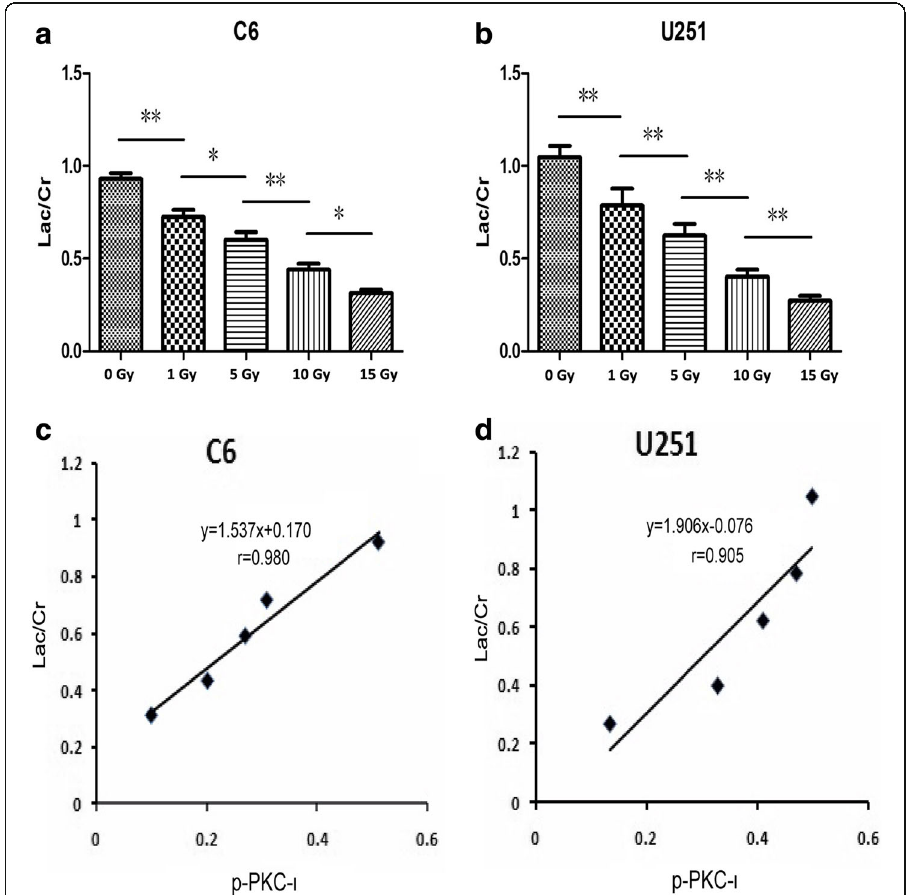
Fig. 4 The Lac/Cr ratios were detected using 1 H NMR spectroscopy and analyzed using MestreNova software. a and b – With increasing X-ray irradiation, the Lac/Cr ratios of C6 and U251 decreased significantly. c and d – The Pearson ’ s correlations between the p-PKC- ι level and Lac/Cr ratio were analyzed using SPSS 17.0. The p-PKC- ι level and the Lac/Cr ratio exhibited a positive linear correlation (r C6 = 0.980 and r U251 =